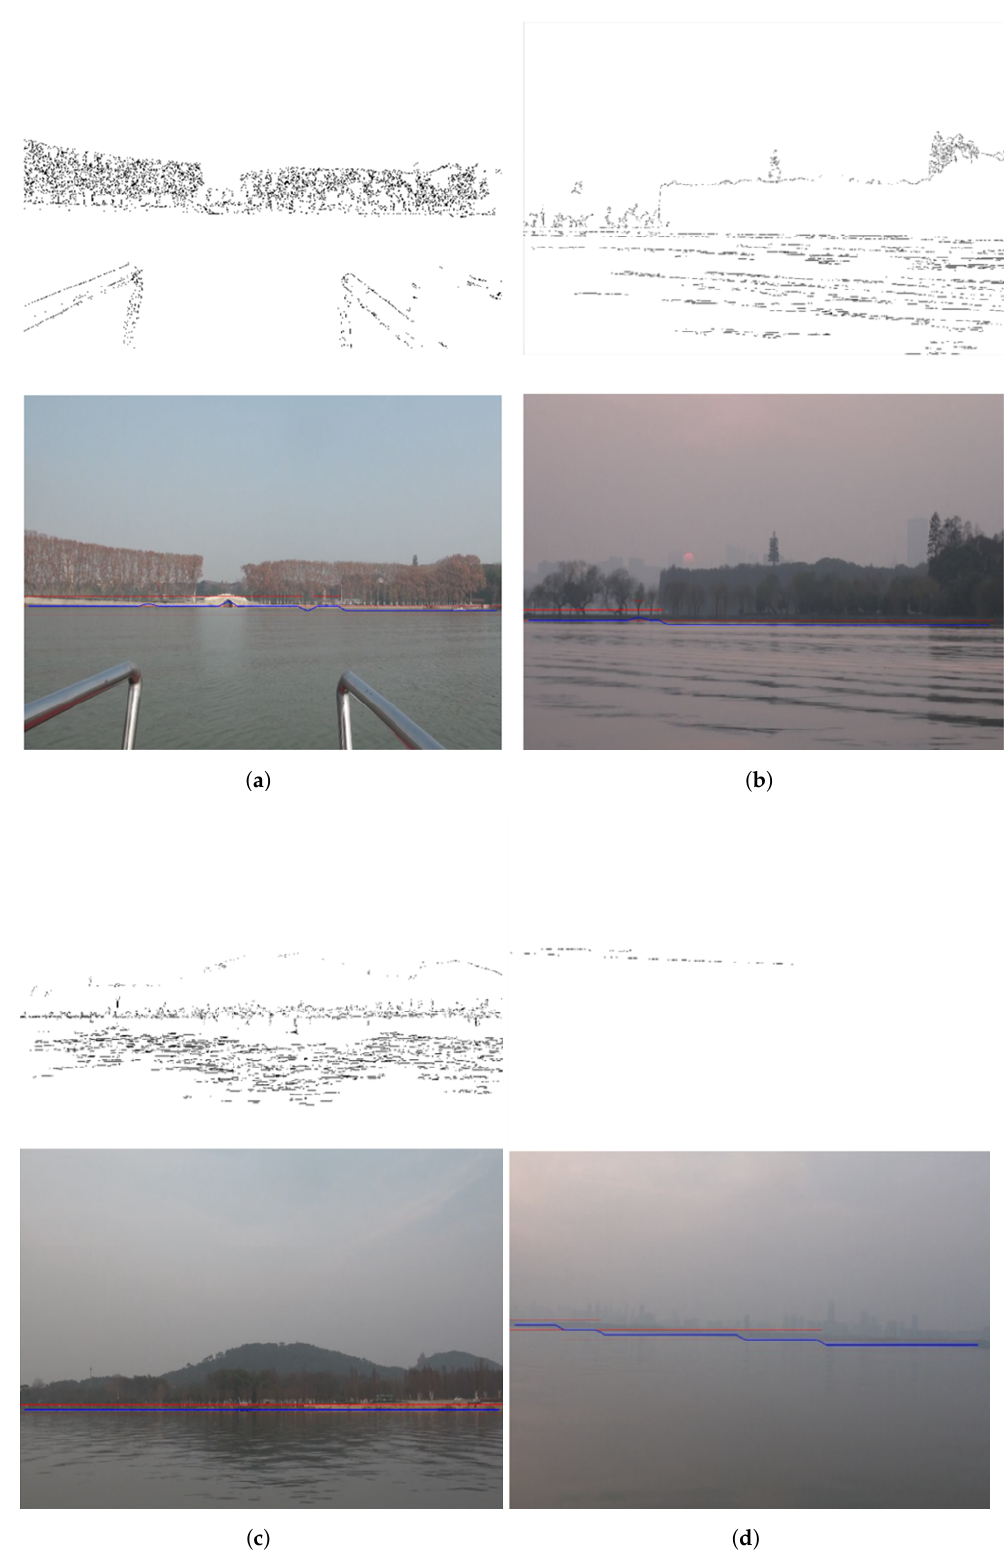
Figure 8. Visual comparison of results between edge detection method (upper) and ours (bottom) with different environmental interference variables: ( a ) linear objects, e.g., rails of the USV, ( b ) water ripples, ( c ) shadow, ( d ) fog. (In our results, blue line shows the estimated waterline, and red line acts as the subline for marking manually the ground